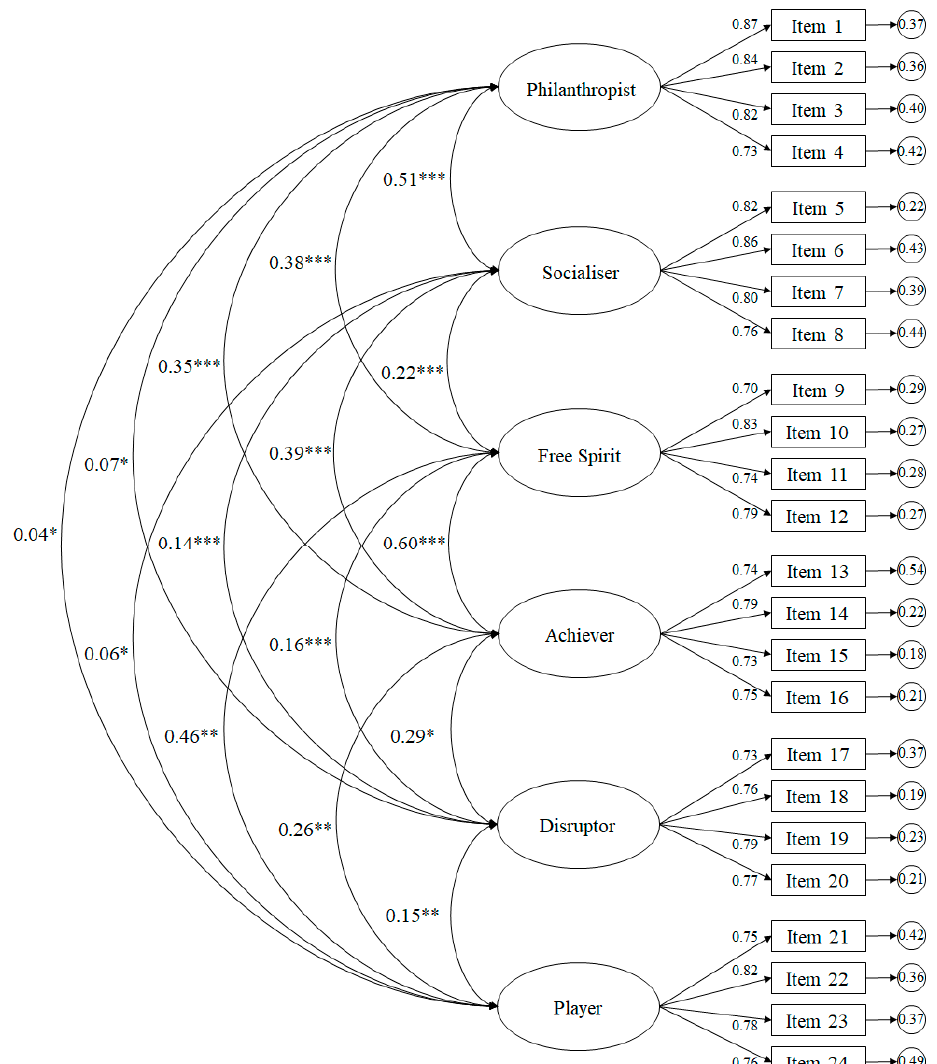
Figure 1. Confirmation factor analysis of the questionnaire. The ellipses represent the factors and the rectangles represent the di ff erent items. The residual variances are shown in the small circles. * p < 0.05, ** p < 0.01, *** p <